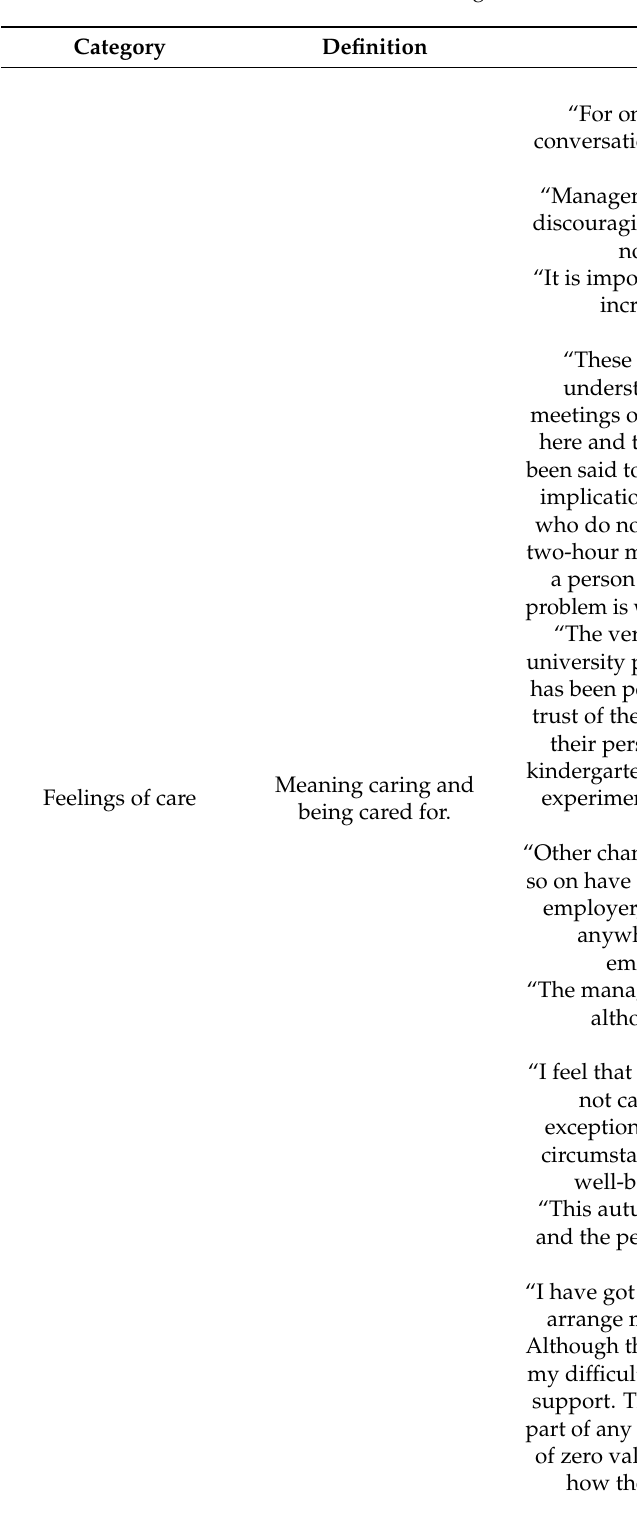
Table 2. Feelings of care affecting the experience of relatedness at remote